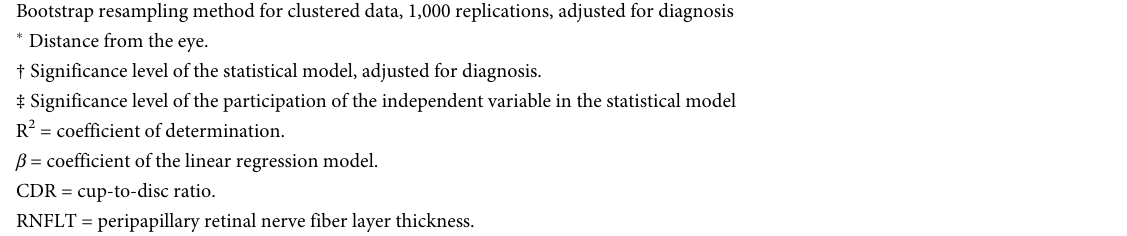
Distance from the eye.